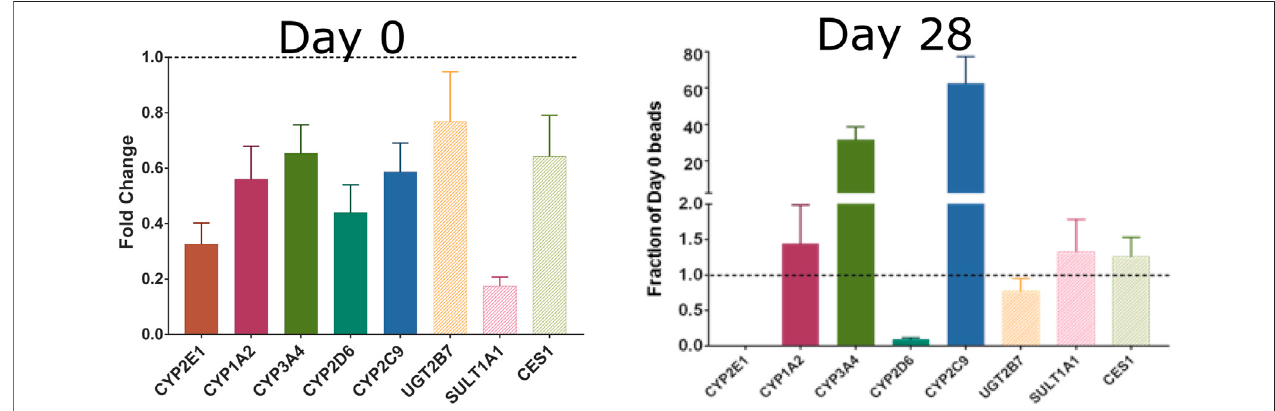
FIGURE 4 | Expression of Phase I and II metabolism genes in freshly plated rat hepatocytes (left) or rat hepatocytes cultured for 28 days in alginate beads. Reproduced from Phillips et al., 2018.